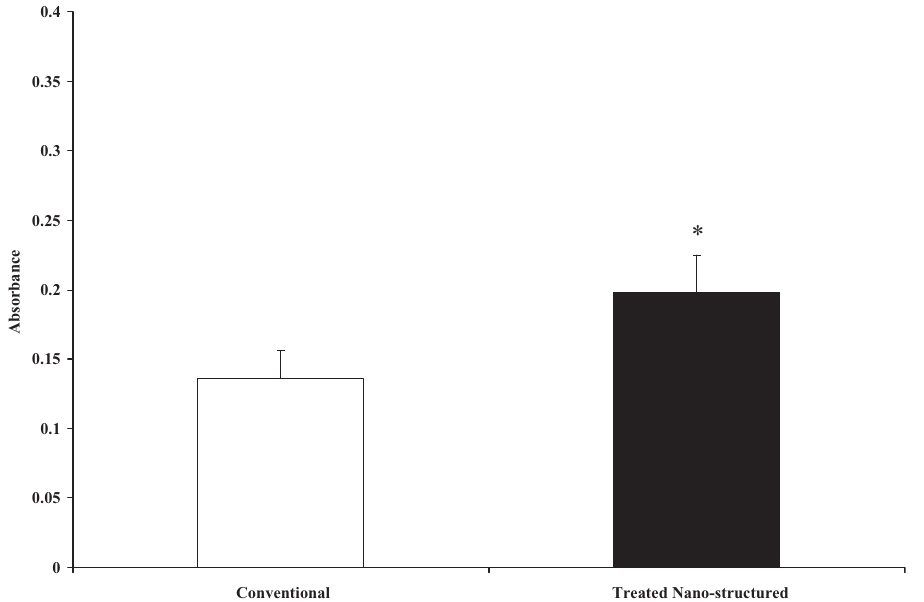
Figure 4 ELISA results indicated that nano-structured PLGA adsorbed more vitronectin from serum-containing media compared to conventional